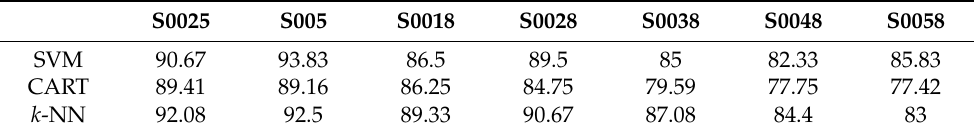
Table 5. The performances of different multi-segment feature extraction strategies.